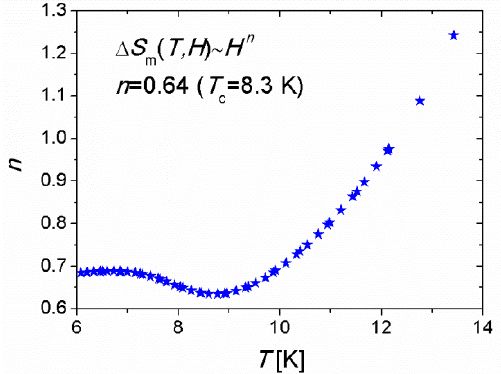
Figure 17. Temperature dependence of exponent n for 3 .